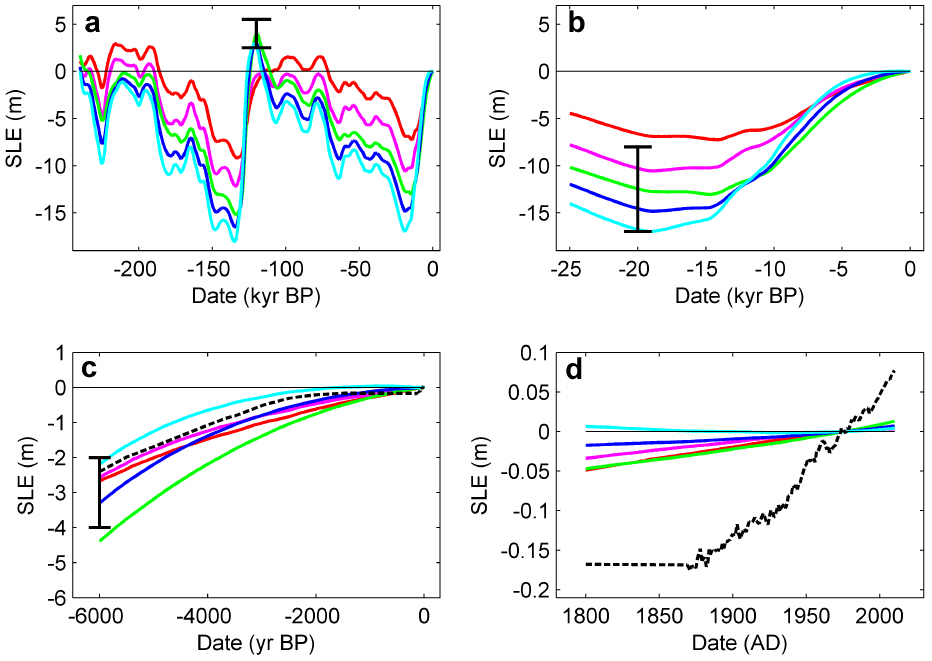
Figure 6. Hindcasts of sea level equivalent (SLE) from changes in AIS ice volume for the five model configurations in Table 2 and for the period 240kyrBP to AD2010. The hindcasts are plotted relative to present-day values (means for AD1961–1990). Shown are results for the original (but corrected) Oerlemans (2005) model (case 1; red lines), for increased sensitivity of ice flow to sea level (case 2, magenta lines), for increased sensitivity of ice flow to ocean subsurface temperature (case 3, green lines), for increased sensitivity of ice flow to sea level and ocean subsurface temperature (case 4, blue lines) and for high sensitivity of ice flow to sea level and ocean subsurface temperature (case 5, cyan lines). Frames (b–d) are enlarged sections of the full hindcasts shown in (a) . Paleoreconstruction targets for the last interglacial, the last glacial maximum and the mid-Holocene are shown as vertical bars in (a–c) , respectively (see text in Sect. 3 for details). Also shown is reconstructed global mean sea level from 6000BP to the present (black dashed lines in (c) and (d) ; see Appendix A for